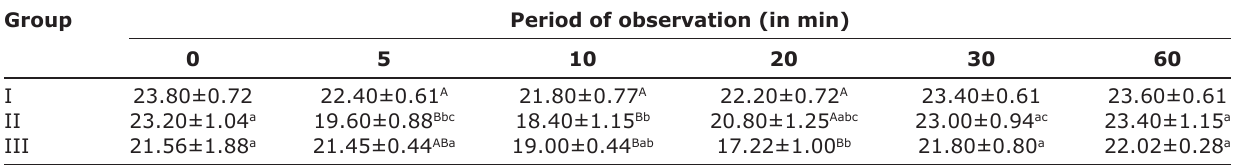
Table-2: Mean±SE value of respiration rate (per min) of different groups at different time intervals of observation. Group Period of observation (in min)